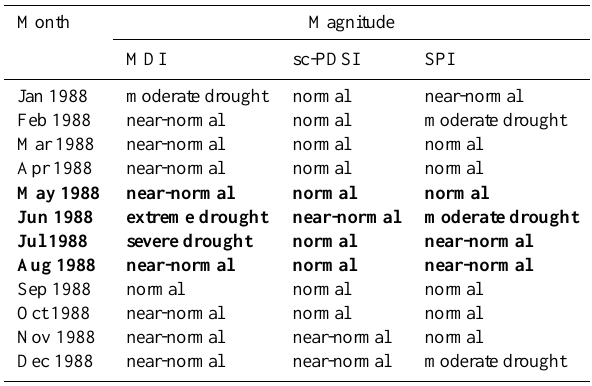
Table 5. The dryness assessment of the 1999/2000 drought by MDI, sc-PDSI and